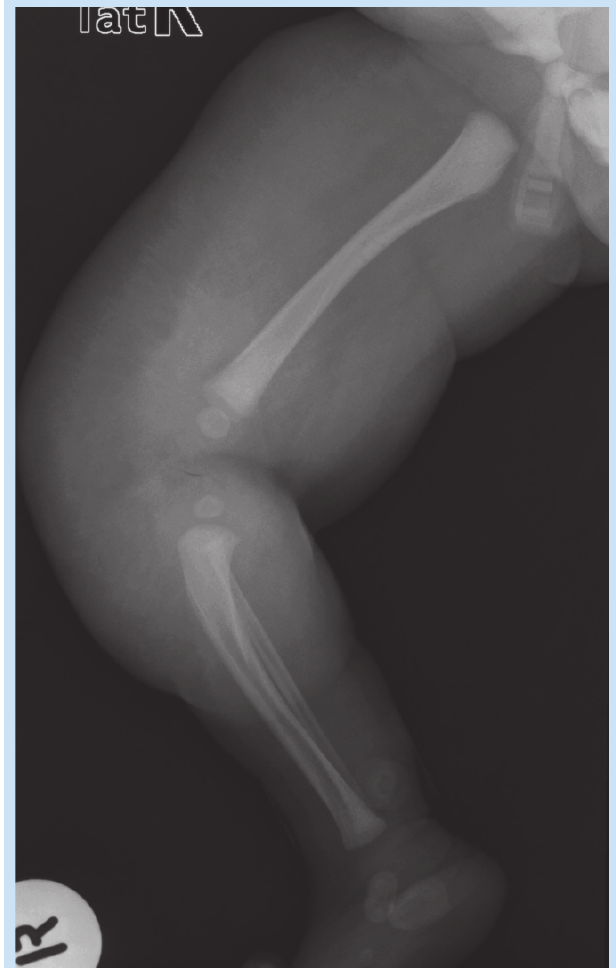
musculature.Fig. 1. Lateral X-ray of the limb demonstrating its enlargement. The thick- ened subcutaneous fat is well